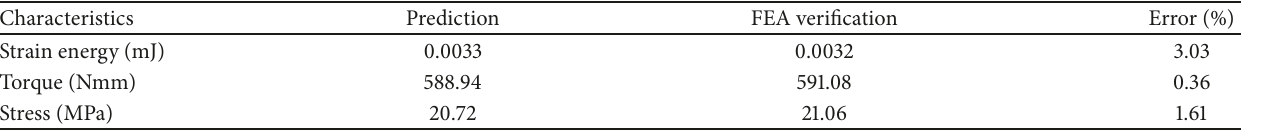
Table 9: Validation